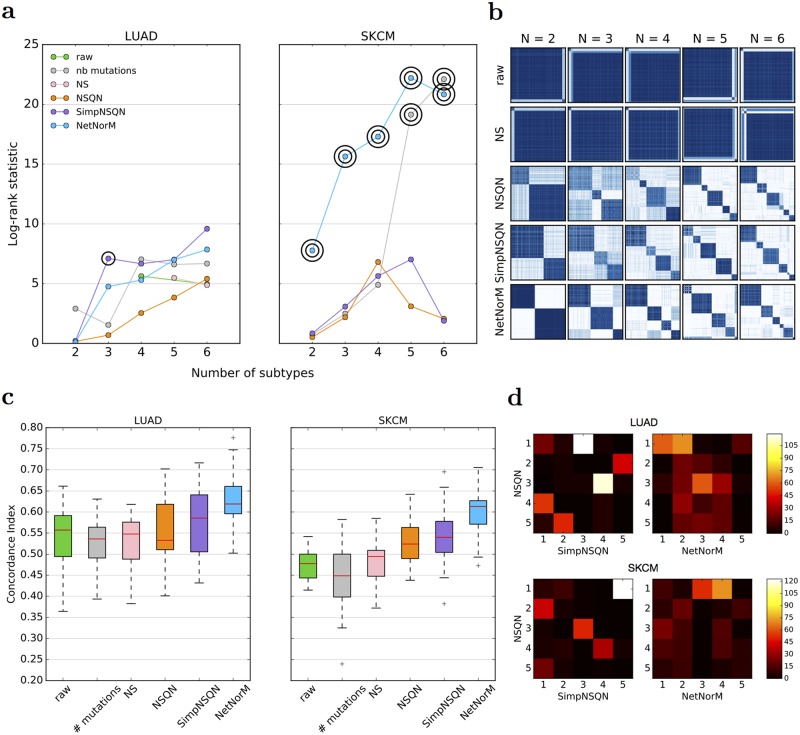
Exploring NSQN and NetNorM performances levers.(a) Subtypes log-rank statistic obtained for LUAD (left) and SKCM (right). One circle indicate a P-value P ≤ 5 × 10−2 and two concentric circles indicate P ≤ 1 × 10−2 (log-rank test). (b) Consensus clustering matrices for LUAD. (c) Survival prediction performances for LUAD (left) and SKCM (right). (d) Confusion matrices for LUAD (top) and SKCM (bottom) comparing the subtypes obtained with NSQN and SimpNSQN on the one hand, and NSQN and NetNorM on the other hand. (a, b, c, d) were obtained with Pathway Commons.